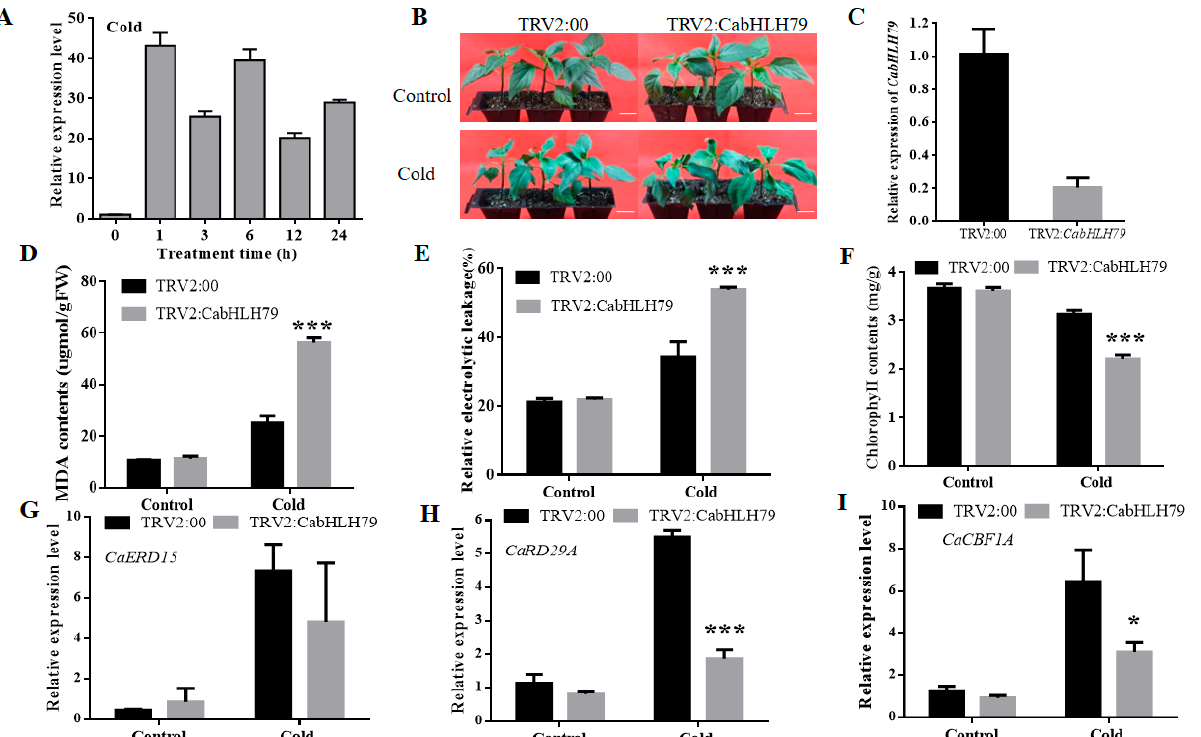
Figure 2. The measurement of physiological indices of CabHLH79 -gene-silenced pepper plants under cold stress. ( A ) The expression level of CabHLH79 under cold stress. ( B ) The phenotype of pepper plants with reduced expression of CabHLH79 under cold stress used virus-induced gene silencing (VIGS). The white line is used as a scale bar (length 2 cm). ( C ) The silencing efficiency of CabHLH79 . ( D – F ) malondialdehyde accumulation (MDA), relative electrolyte leakage (REL), chlorophyll con- tents. ( G – I ) RT-qPCR analysis of CaERD15, CaRD29A, CaCBF1A. All data of three independent biological replicates were expressed by Means ± SDs. * representing significant difference (* p < 0.05, *** p <